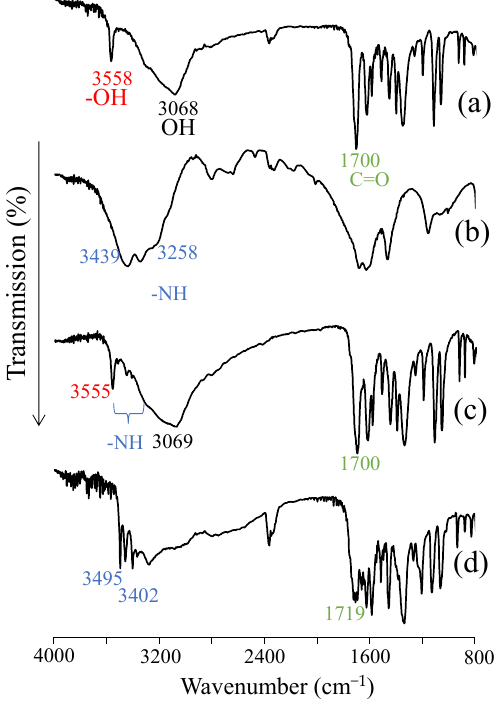
Figure 7. FT-IR absorption spectra of EA/UR systems. ( a ) EA; ( b ) UR; ( c ) PM (EA/UR = 1/1); and ( d ) EVP (EA/UR = 1/1).